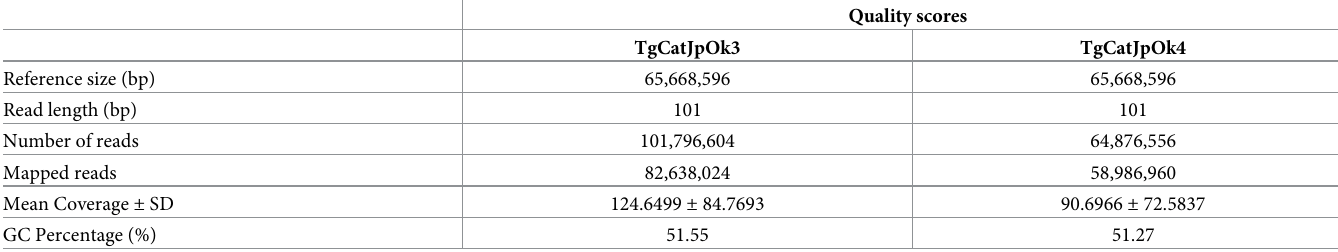
Table 2. Quality data of whole-genome-sequence and